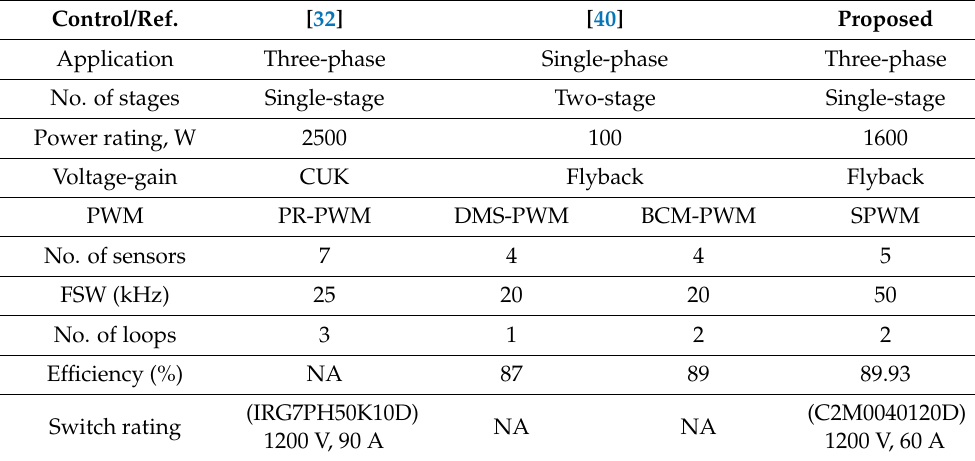
Table 2. Comparison of IFBI with counterpart structures considering the control